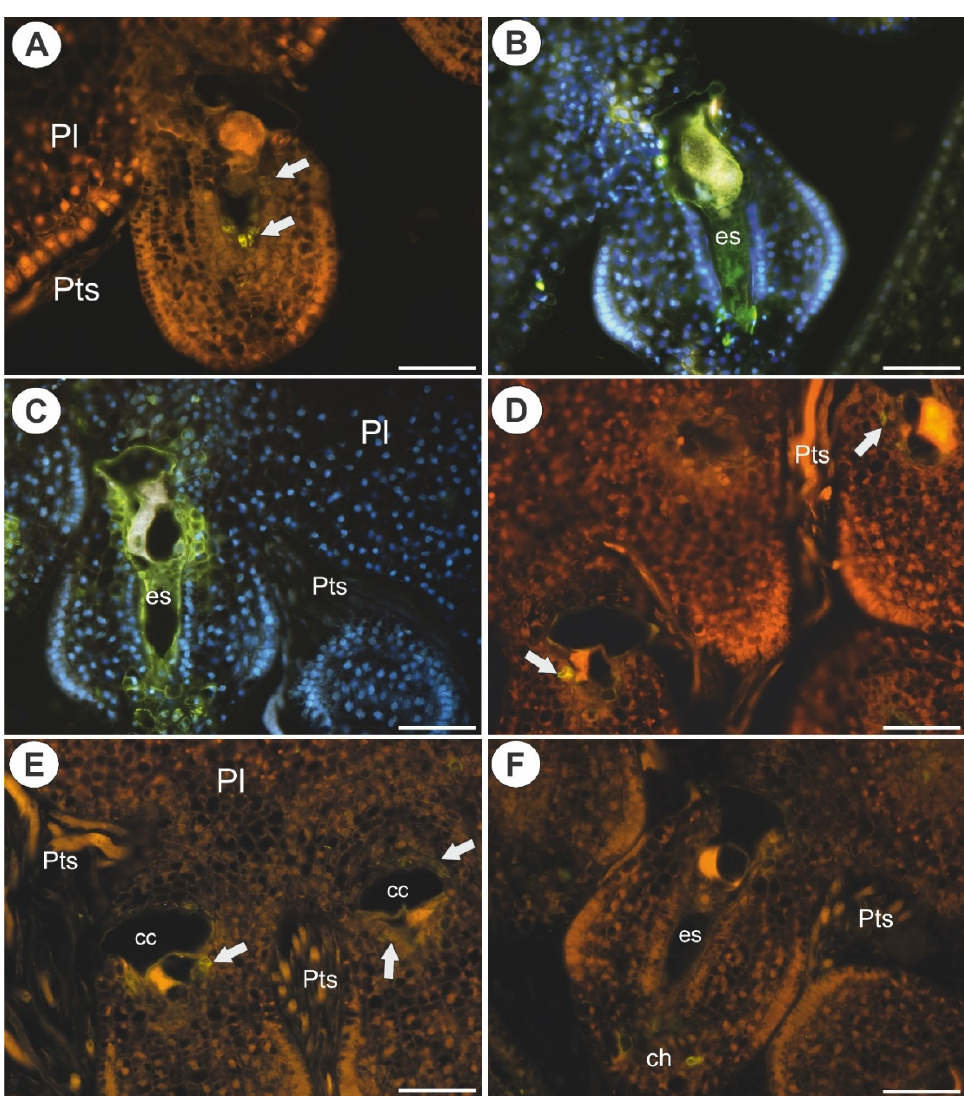
embryo sac (es). ( E ) Arabinogalactan protein (labeled with JIM14) detected in U. nelumbifolia: in- tegument (In), nutritive tissue (Nt), egg cell (white arrow). ( F ) Arabinogalactan protein (labeled with JIM14, green fluorescence) detected in U. humboldtii: placenta (pl), chalaza (ch), egg cell (white arrow). All bars 50 µm.